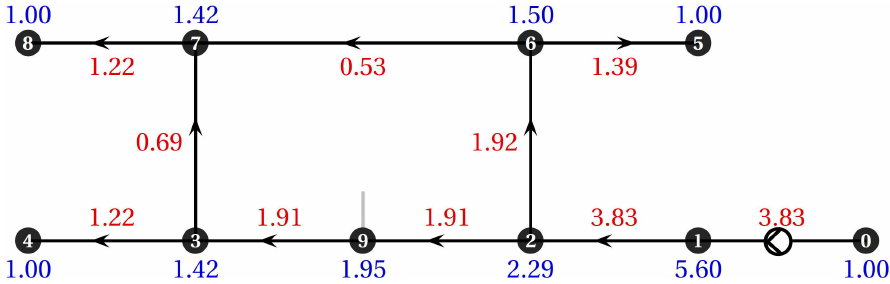
Figure 6. Pressures and flows in the network without leakage.